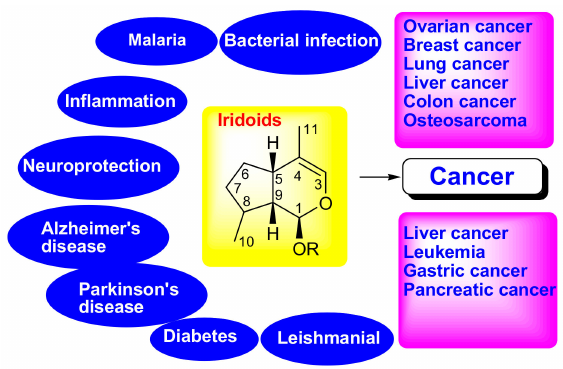
Figure 2. Therapeutic applications of